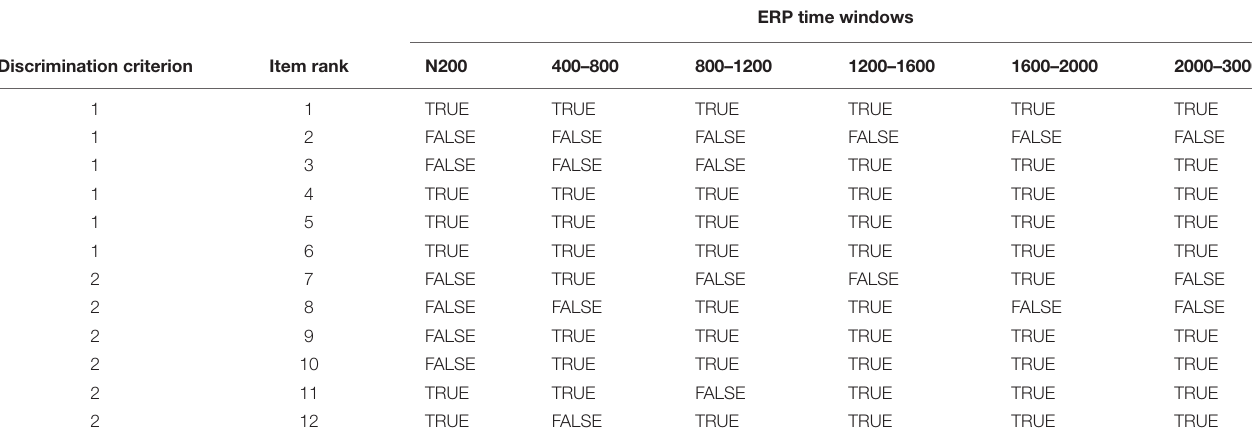
TABLE 2 | Verification of statements related to discrimination criteria